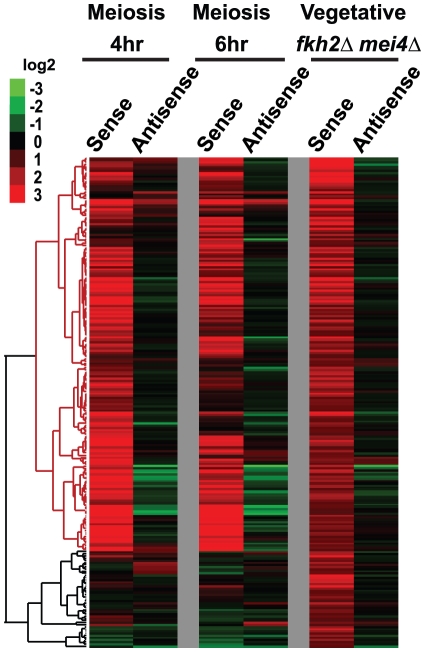
Fkh2 represses expression of mid-meiotic genes.Expression levels for sense and antisense RNAs were calculated using the average probe intensity method. The results presented here are the differences between samples and vegetative cells (e.g., meiosis 4 hr sense level – vegetative sense level). 229 genes that were induced in the fkh2Δ mei4Δ strain are shown (cutoff: sense level fkh2Δ mei4Δ -WT >1), which include 31 of the 65 “red dot” genes from Figure 2 (p<<10−10). Over 75% of these genes are also induced in middle meiosis. Data from meiosis 4 hr, 6 hr and the fkh2Δ mei4Δ strain were hierarchically clustered, showing the similarity of regulation of these genes in meiosis and in the mutant. At the bottom of the figure is a sub-cluster of 45 genes induced in the mutant, but not in meiosis; 8 of these genes have no associated GO term, and 18 of these genes respond to stress (p = 0.0006). Red is induced; green is repressed.